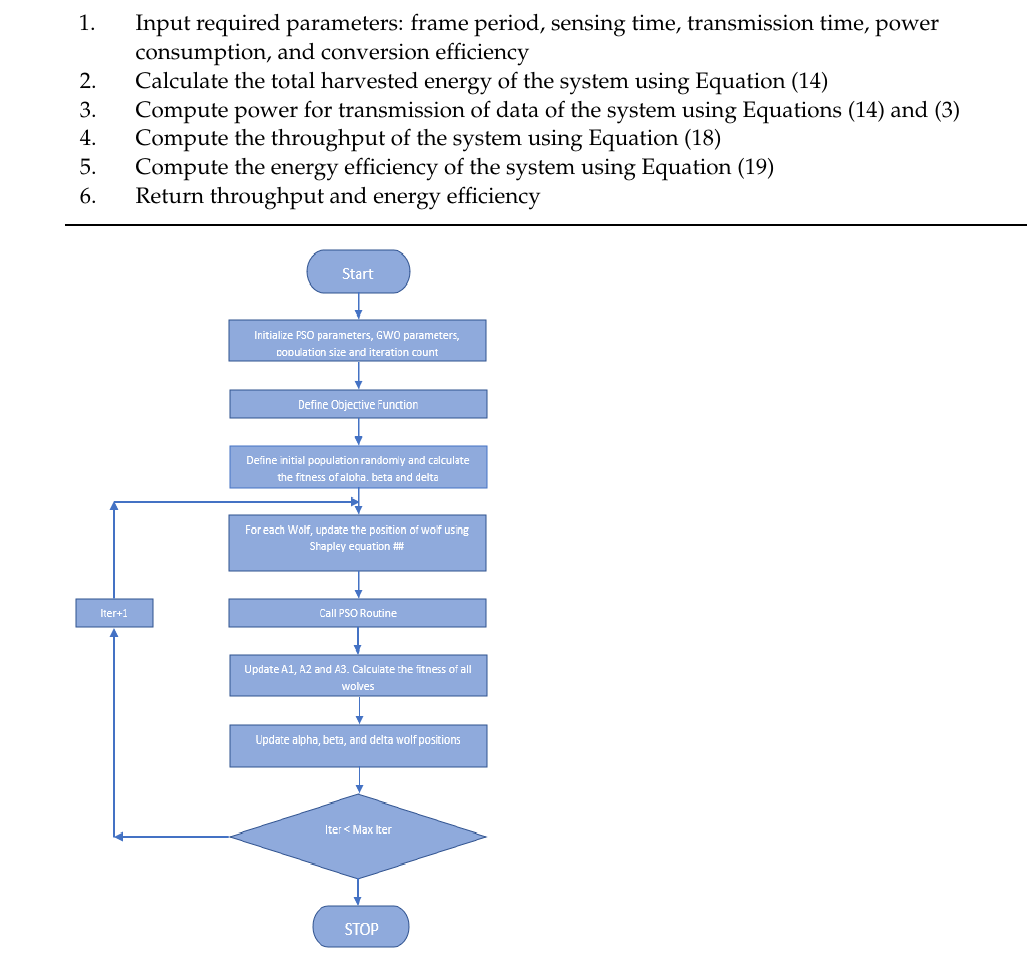
Figure 4. Flowchart of the Shapley hybrid multi-objective optimization